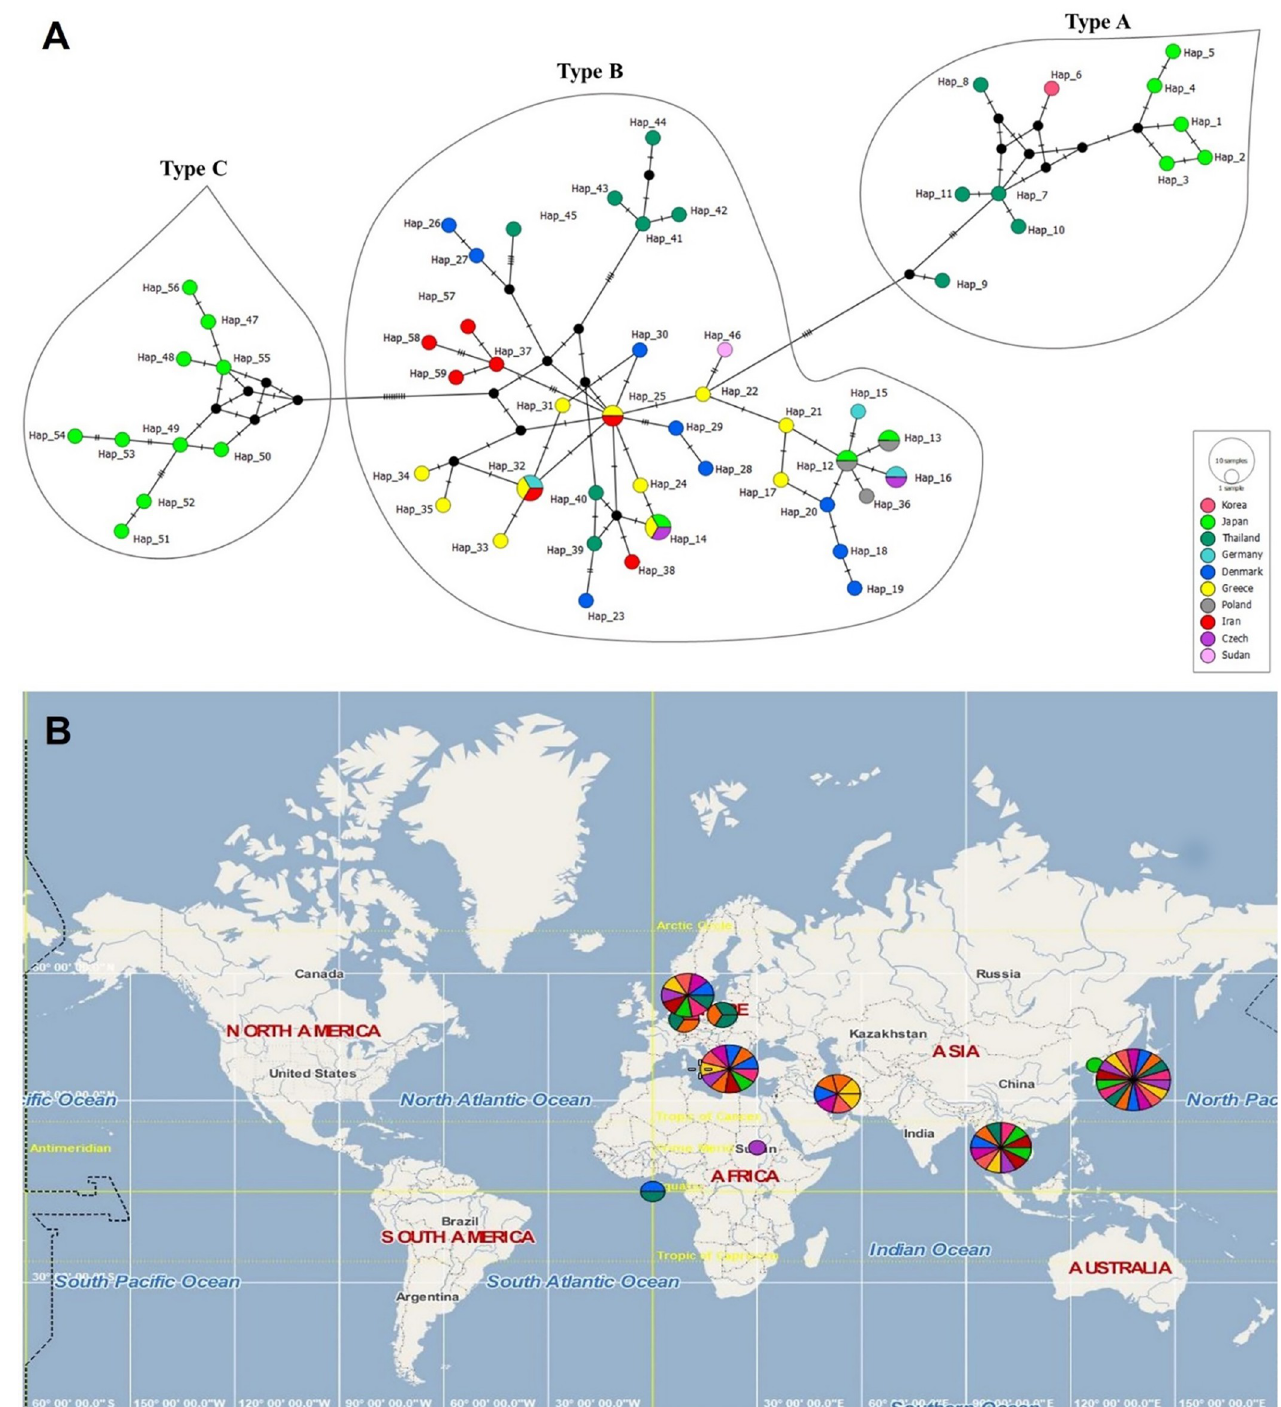
Fig 6. Median-joining network analysis of haplotype inferred from cox 1 sequences (333 bp) of E . vermicularis using PopArt 1.7 software (http://popart. otago.ac.nz). Eighty-seven sequences were distributed among 59 haplotypes (12 sequences from this study and the rest from other studies in the NCBI database). All the sequences from this study belonged to type B. Each circle represents a haplotype, and its colors represent a country. The size of the circle indicates the relative frequency of sequences belonging to a particular haplotype. Hatch marks along the network branches indicate the number of mutations. B. Distribution and diversity of different haplotypes of E . vermicularis based on locations on the world map. Each color represents a different geographical location. PopArt software was used to place sample locations for sequences on the map panel (http://popart.otago.ac.nz/index.shtml) [28]. The map interface was implemented using the Marble library (http://marble.kde.org), which is distributed according to the GNU Lesser General Public License (LGPL), Version 2